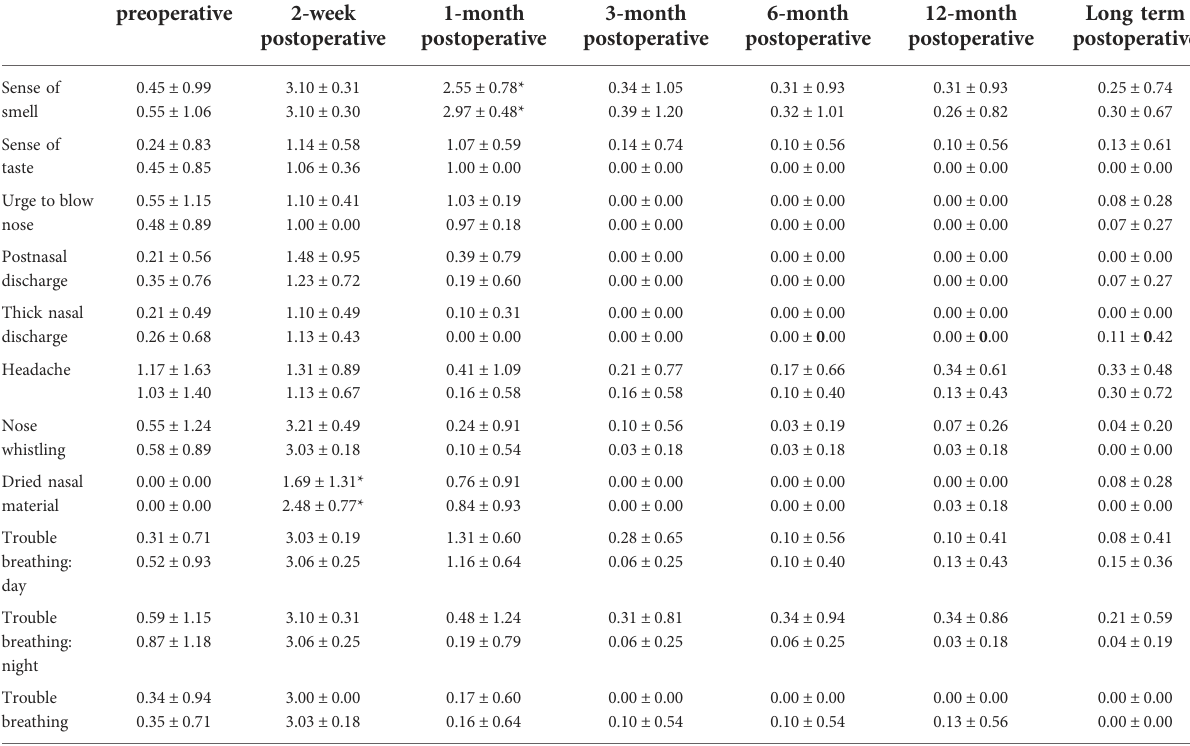
TABLE 5 Comparison of ASK nasal-12 between OETA and BETA.